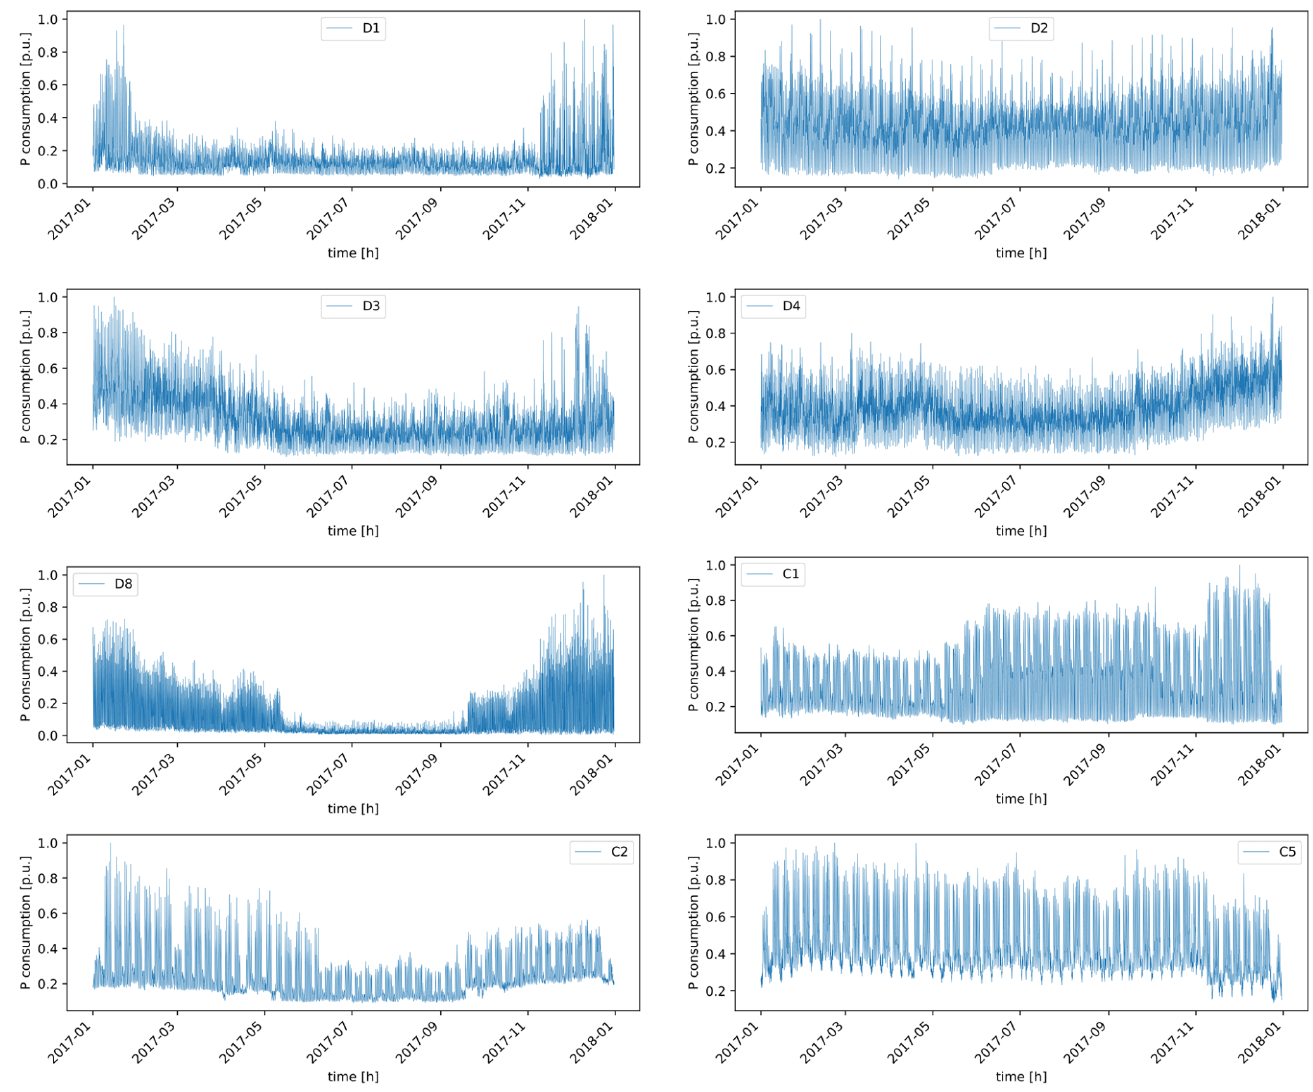
Figure 4. Yearly load shape curves used in the